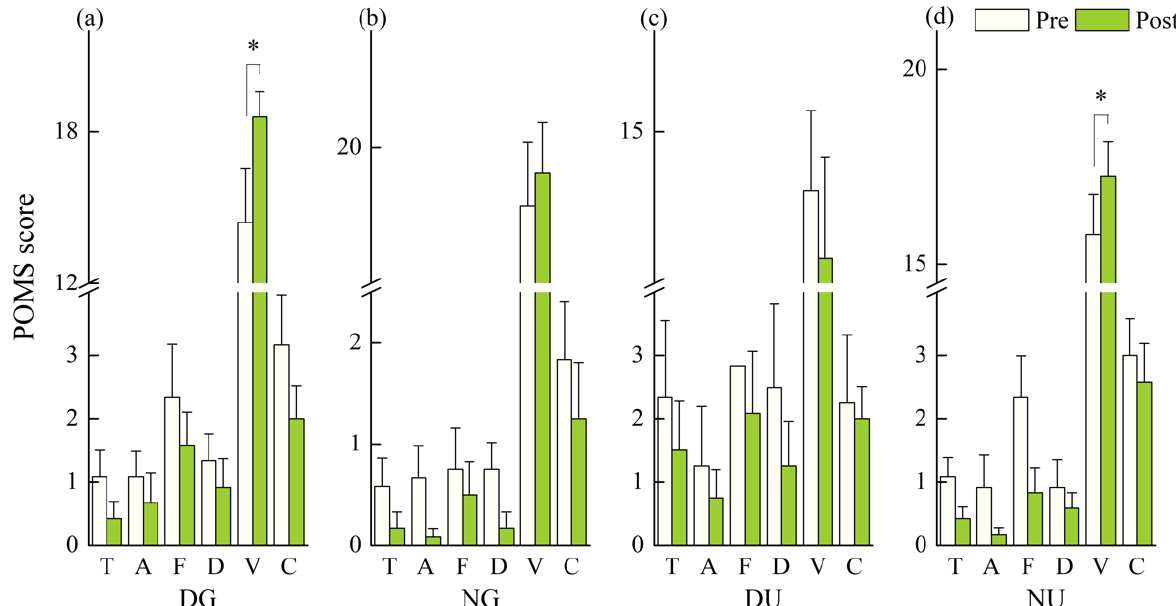
Figure 4. Outcomes of Profile of Mood States (POMS) subscales in: ( a ) daytime green walking; ( b ) nighttime green walking; ( c ) daytime urban walking; and ( d ) nighttime urban walking. T: Tension or anxiety; A: Anger or hostility; F: Fatigue; D: Depression or dejection; V: Vigor; C: Confusion or bewilderment. The error bar represents standard error, and * represents p < 0.05. Analyzed using Wilcoxon signed-rank test ( N = 12).